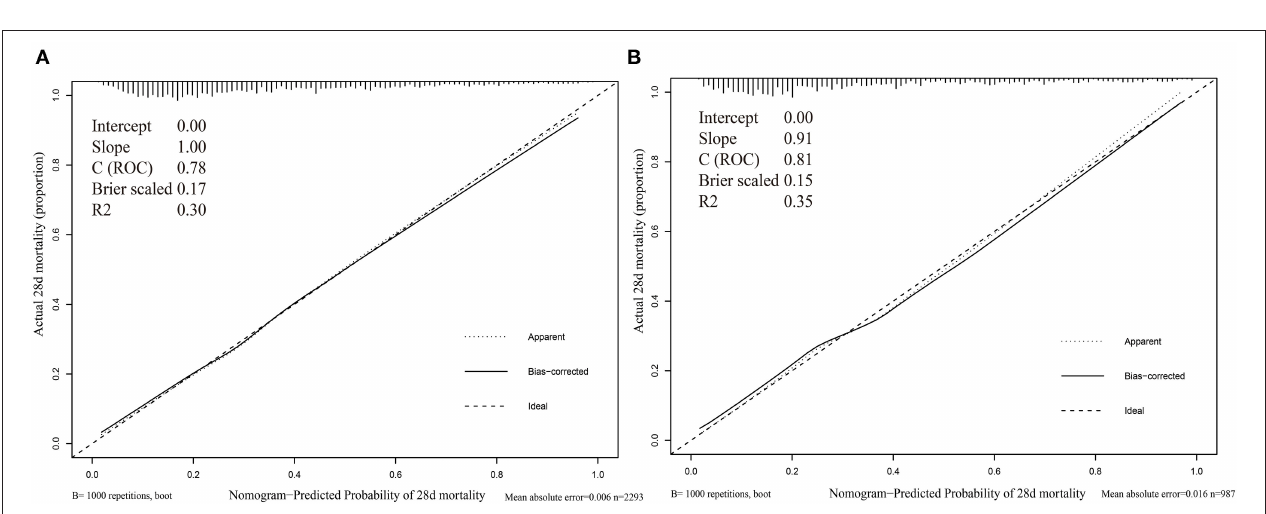
FIGURE 3 | Calibration curves of nomogram. (A) Training set; (B) Validation